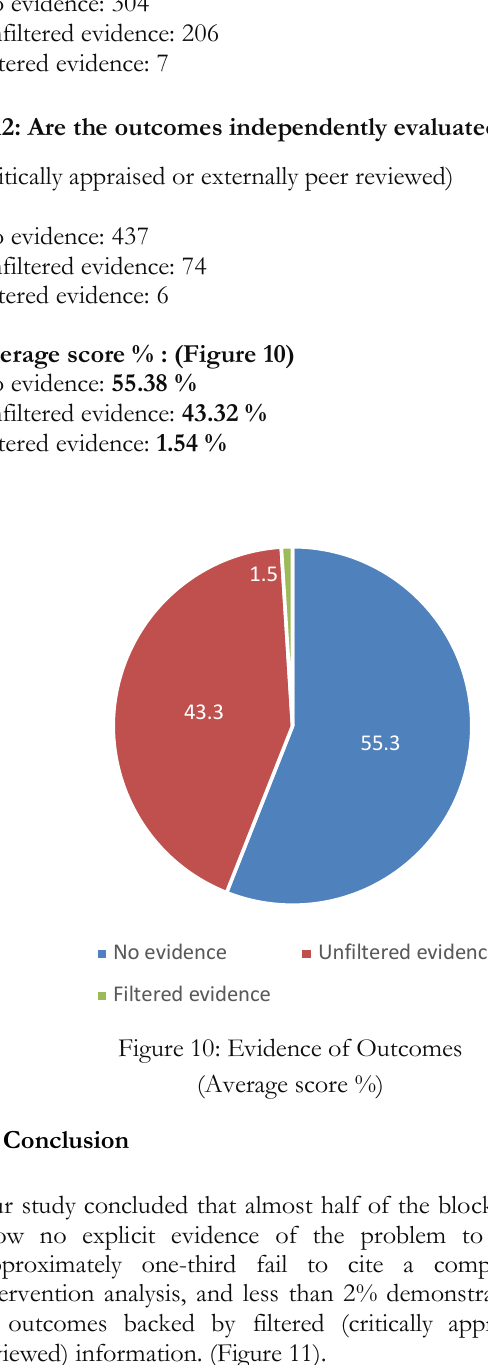
Figure 9: Evidence for the Intervention (Average score %)